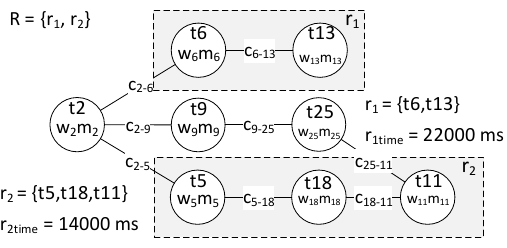
Figure 3. Graph representation of the tasks of an